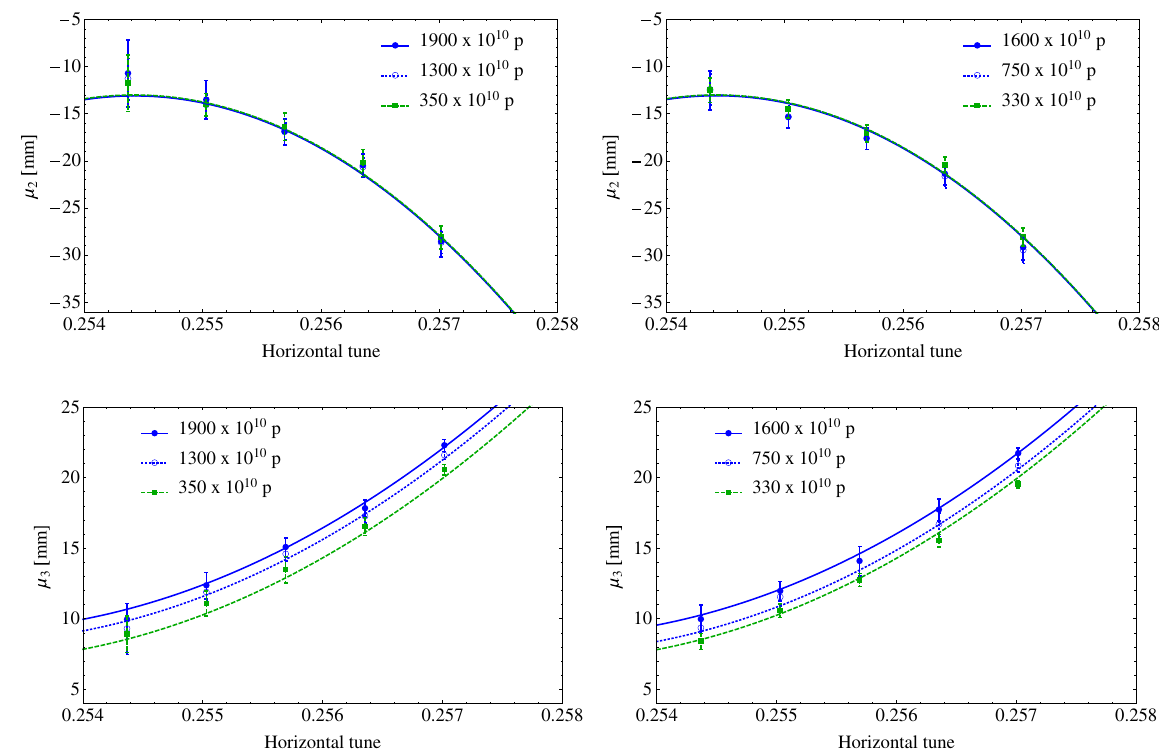
FIG. 14. Beamlets’ position (cid:5) 2 (upper) and (cid:5) 3 (lower) of the data collected during the second experimental campaign vs horizontal tune evolution for three values of the beam intensity. The data from the debunched (left) as well as bunched beam (right) are shown. The quadratic fit functions shown in the plots represent the global fit discussed in the text. The excellent agreement is clearly